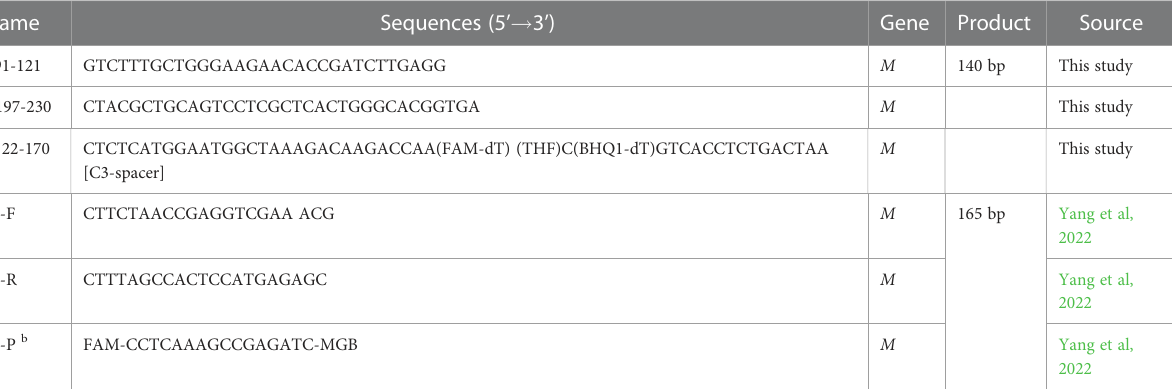
TABLE 1 The primers and probes used in IAVs real-time RT-RAA and RT-qPCR assays. Name Sequences (5 ’ ! 3 ’